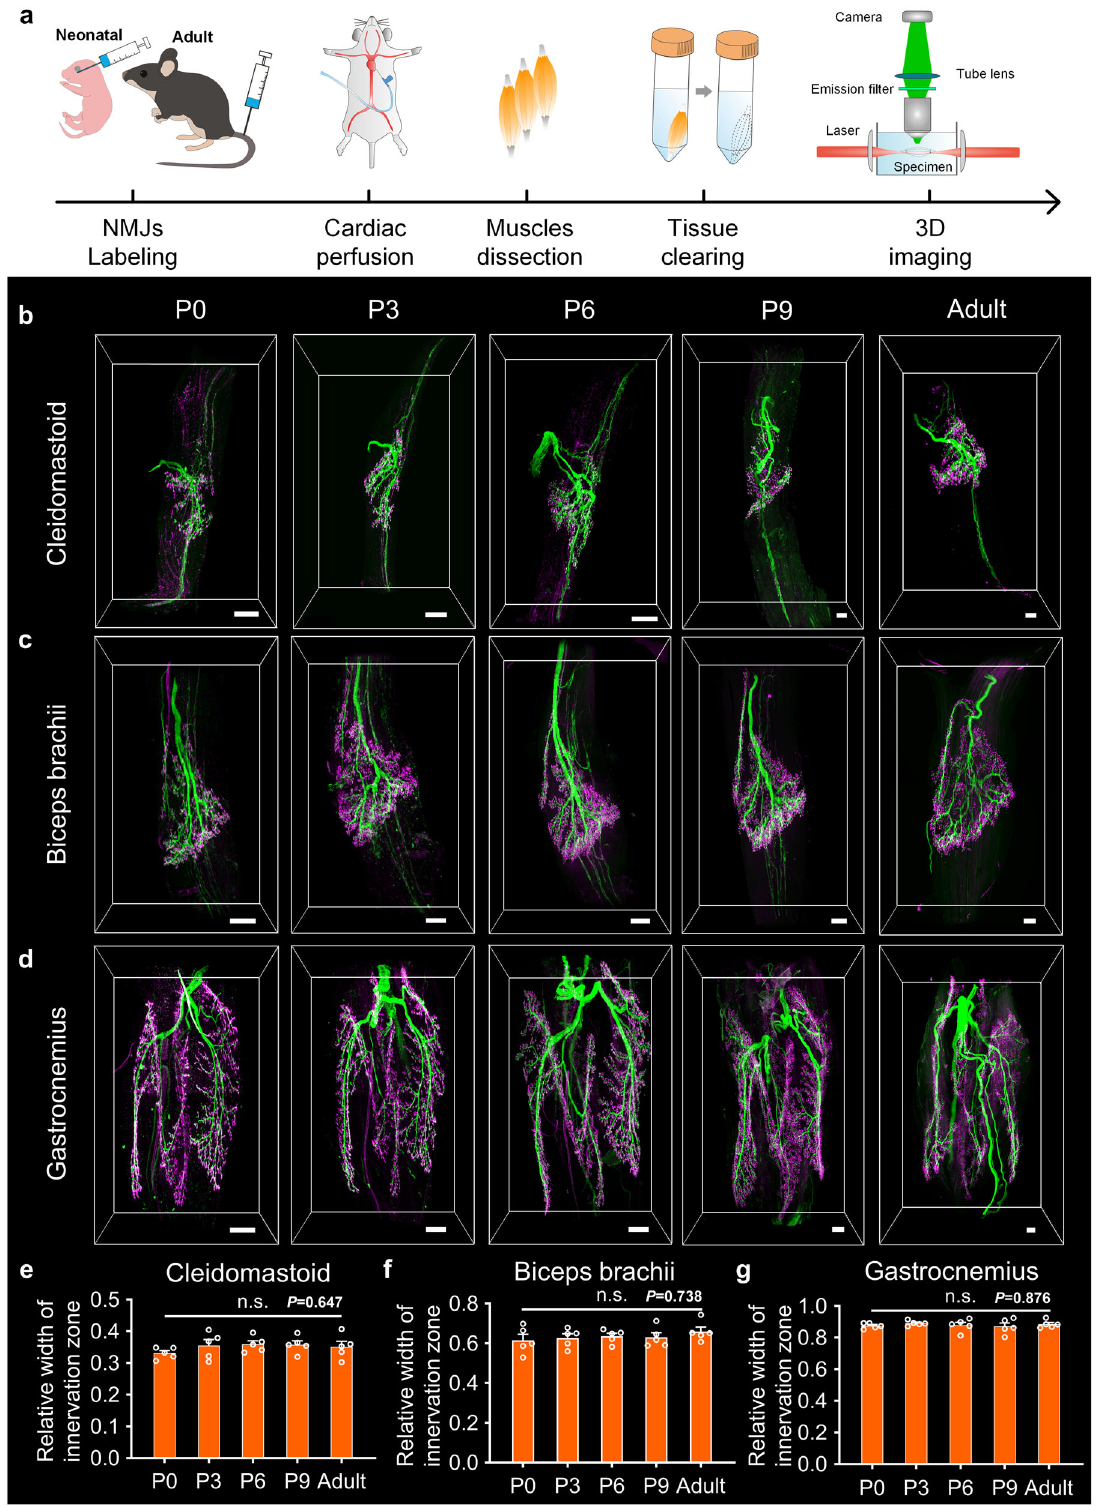
Fig. 3 3D visualization of innervating nerves and NMJs in skeletal muscles after clearing. a The entire experimental process of the 3D imaging of intramuscular motor nerves and NMJs in skeletal muscles. b – d 3D reconstructions of intramuscular motor nerves and NMJs in the cleidomastoid ( b ), biceps brachii ( c ), and gastrocnemius ( d ) during postnatal development and adulthood. Scale bar: 200 μ m. e – g The quanti fi cation of the relative ranges of innervation zones in whole muscles ( n = 5 independent animals for each muscle at each time point). All values are presented as the means ± SEM; statistical signi fi cance in e – g (n.s. represents not signi fi cant) was assessed using one-way ANOVA.